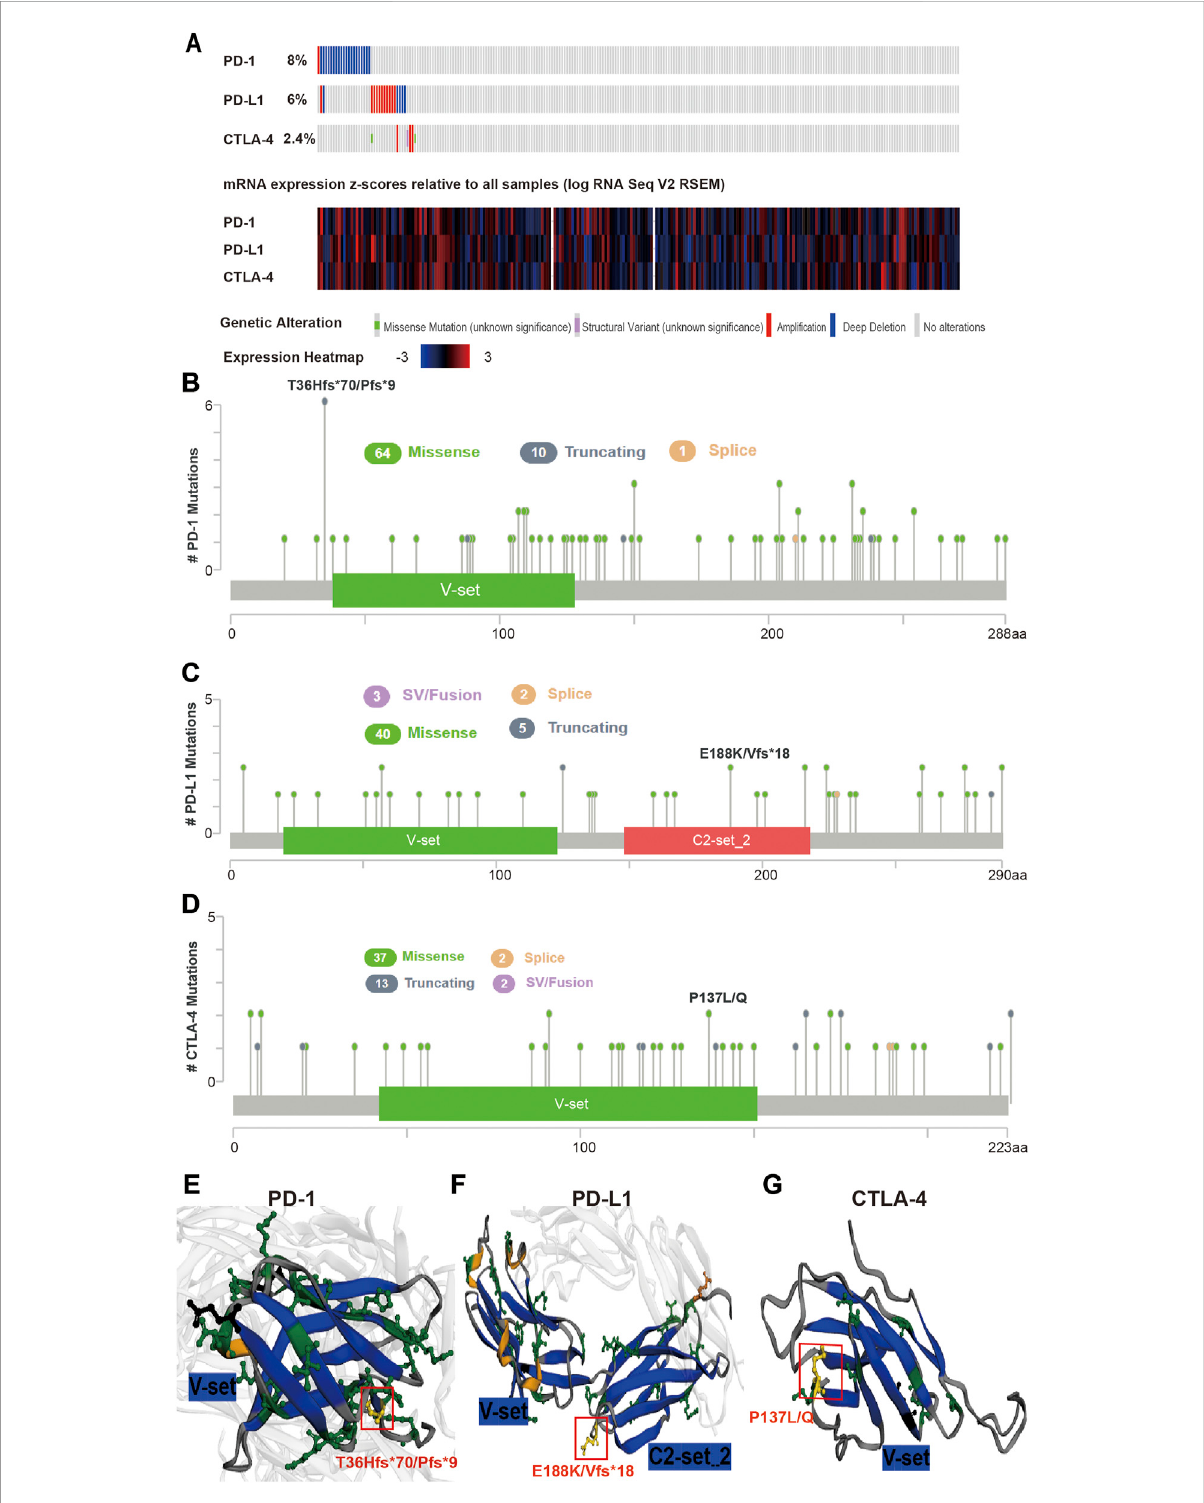
FIGURE 2 Mutation features of PD-1/PD-L1/CTLA-4 in SARC specimens. (A) Genetic alterations and mRNA expression of PD-1/PD-L1/CTLA-4 from all 255 of the human SARC specimens (TCGA, Pancancer Altas) in the TCGA dataset analysed using cBioPortal. A total of 8%, 6%, 2.4% sequenced patientswithSARCexhibitedgeneticalterationsofPD-1,PD-L1,CTLA-4. (B,C,D) Distributionof (B) PD-1, (C) PD-L1,and (D) CTLA-4mutationsitesin sarcoma.Thelocations ofmutationsareshownonthe X -axis(lollipop)andthefrequencyofmutationsonthe Y